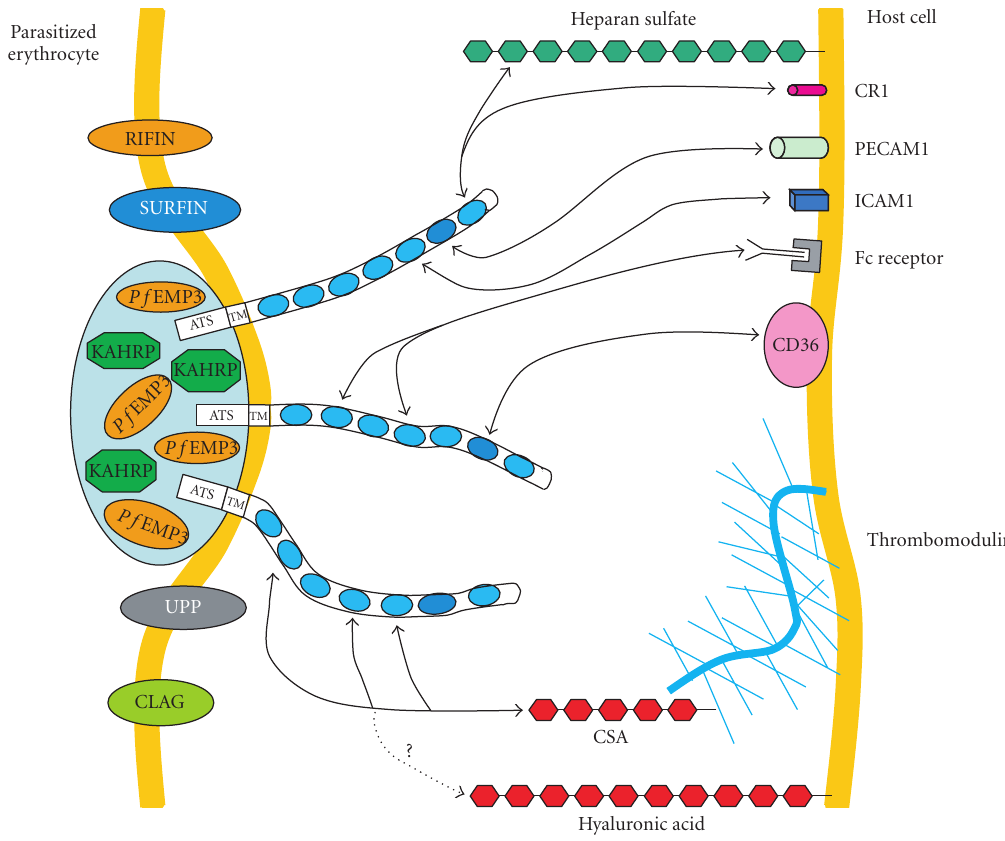
Figure 1: Schematic diagram of knobs showing potential intermolecular interactions between parasites proteins exported on the surface of PRBC and receptors on the host cell surface. P f EMP, Plasmodium falciparum erythrocyte membrane protein; KHARP, knob-associated histidine-rich protein; RIFIN, repetitive-interspersed family proteins; CLAG, cytoadherence-linked asexual protein; CR1, complement re- ceptor 1; ICAM1, intercellular adhesion molecule 1; PECAM1, platelet endothelial cell adhesion molecule 1; CSA, chondroitin sulphate A; UPP, uncharacterized parasite proteins. The question mark “?” means that the binding to hyaluronic acid is